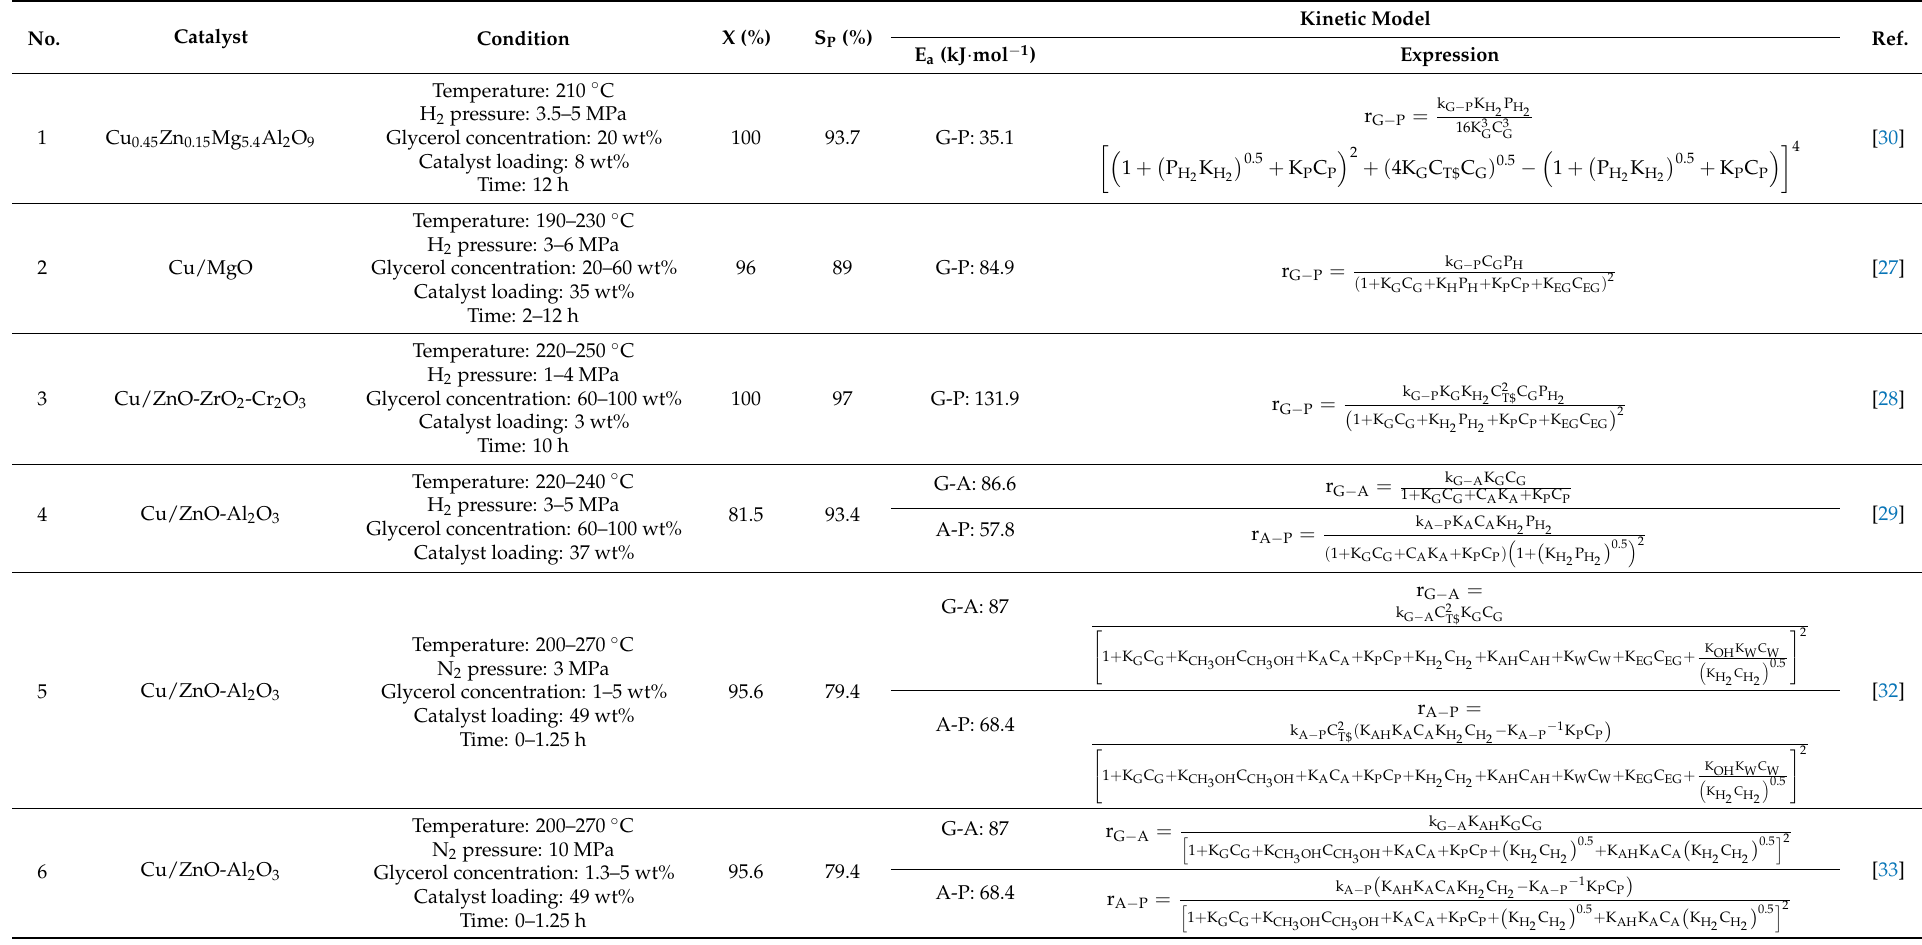
Table 3. Mechanistic models for glycerol conversion over Cu-based